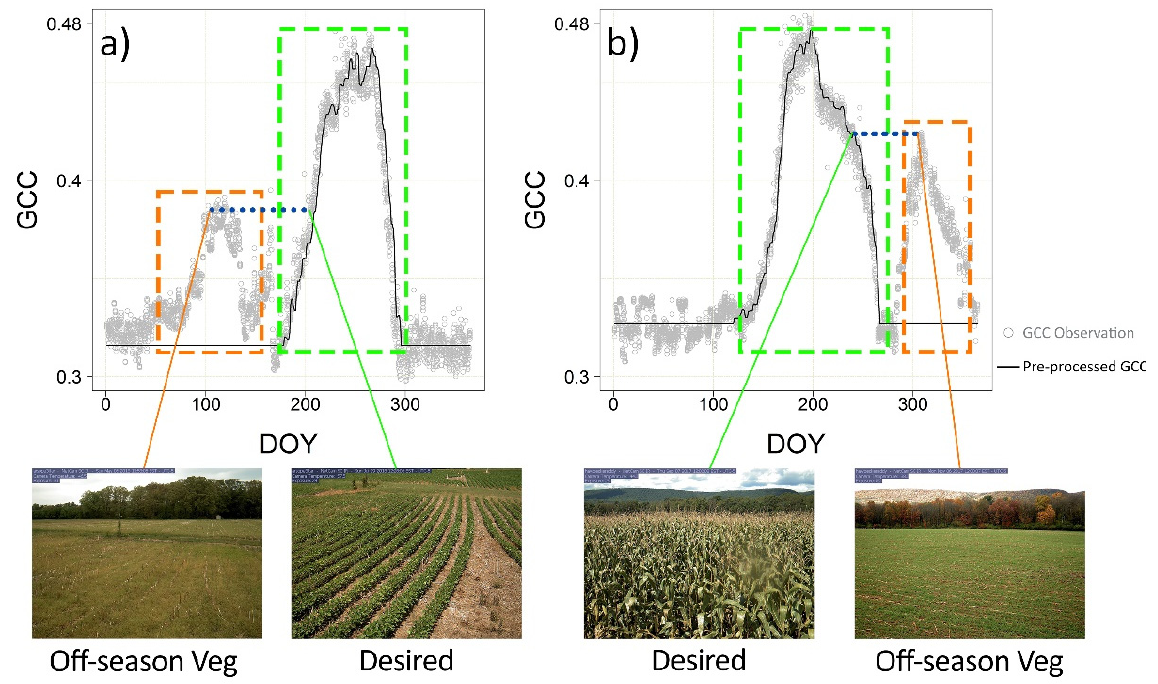
Figure 3. The influence of dormant season vegetation on the PhenoCam GCC time series curves. ( a ) The dormant season vegetation is before the growing season; ( b ) The dormant season vegetation is after the growing season. The GCC time series was pre-processed with off-season fluctuations replaced by the median dormant season values.